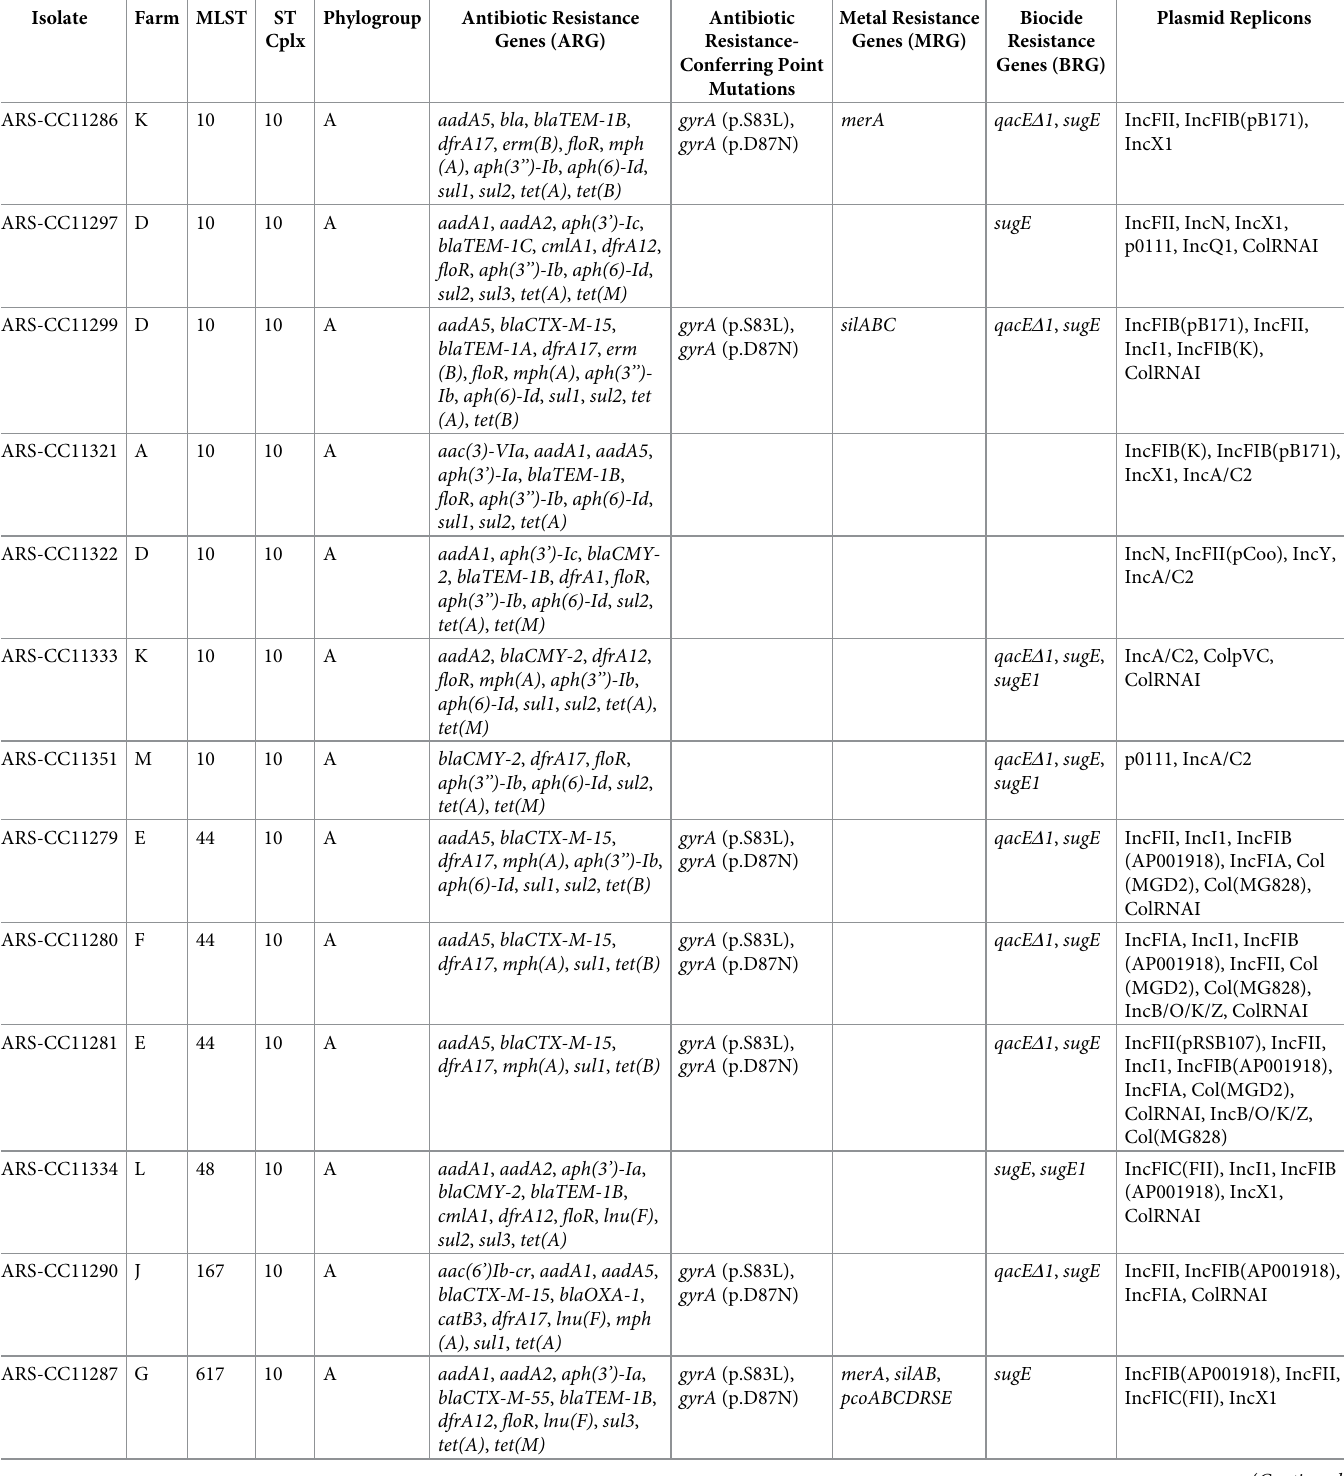
Table 1. Characteristics of MDR and susceptible strains. Columns show farm from which the isolate was collected, MLST, ST Cplx, antibiotic resistance, metal resis- tance, and biocide resistance